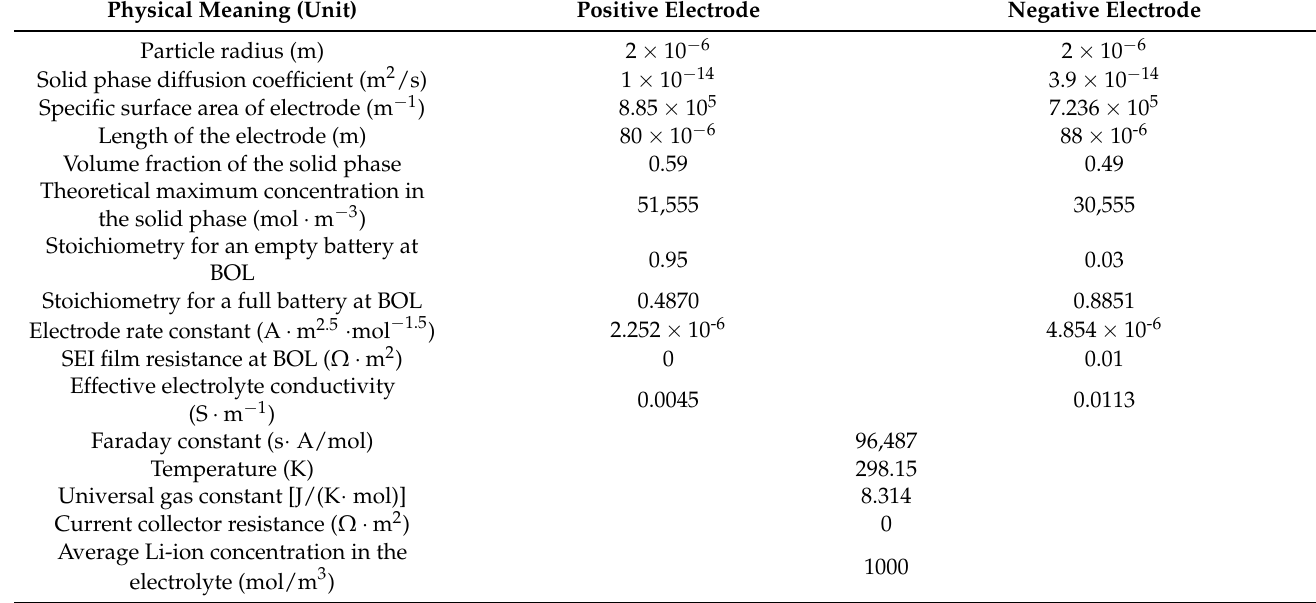
Table A3. Battery